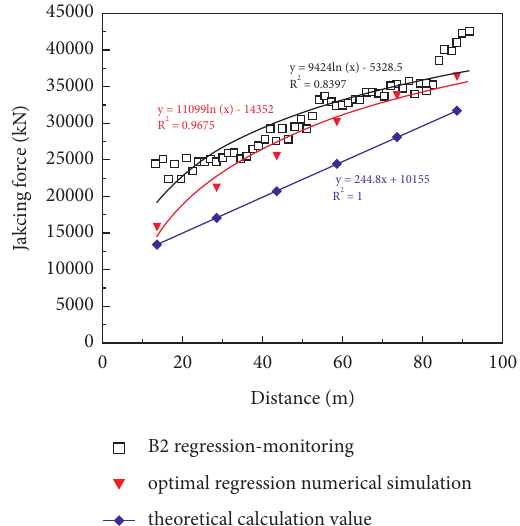
Figure 15: The comparison of jacking forces from monitoring, the empirical equations of B2, and the displacement control method for case B1 of optimal program (program